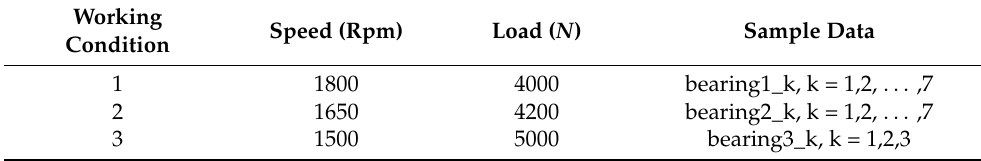
Table 2. The specific information of the sample